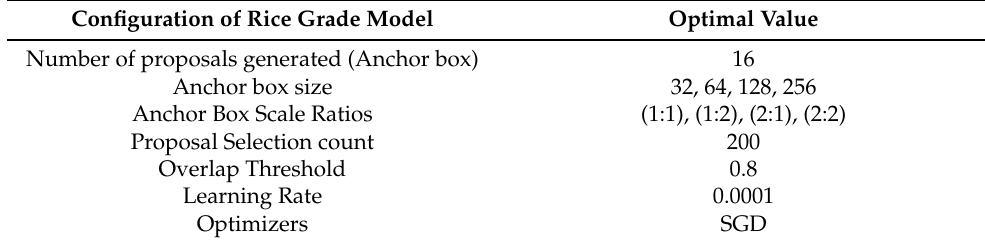
Table 3. Configuration parameters used to build the proposed